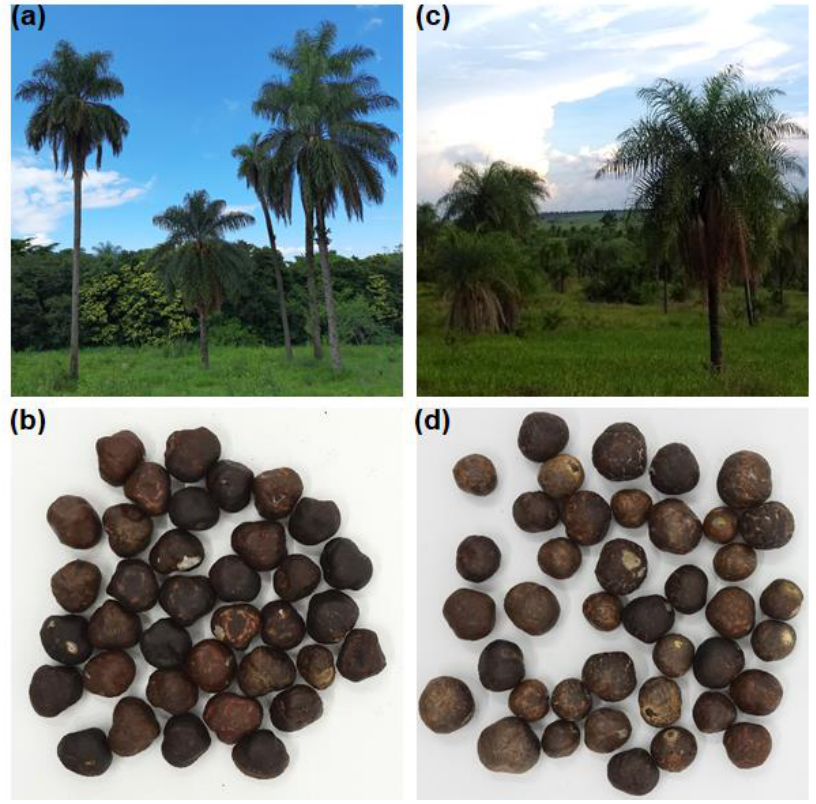
Figure 1. ( a ) Macauba palms and ( b ) kernels of Acrocomia aculeata . ( c ) Macauba palms and ( d ) kernels of Acrocomia totai .